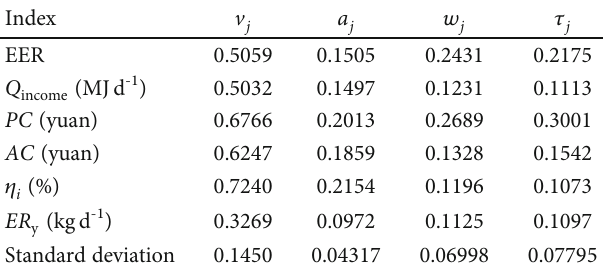
Table 11: The variation coe ffi cient and weight of each